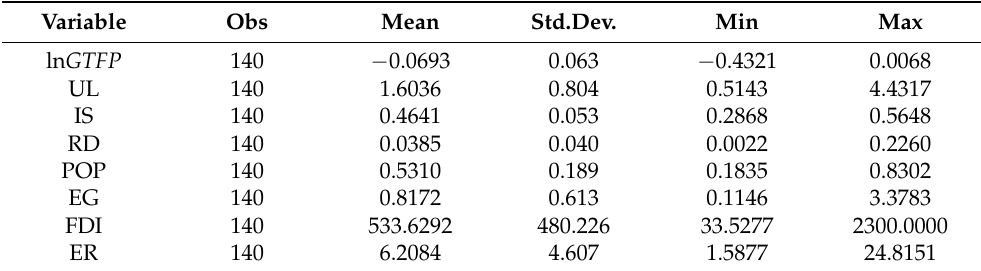
Table A2. Descriptive Statistics of Variables of the Central China